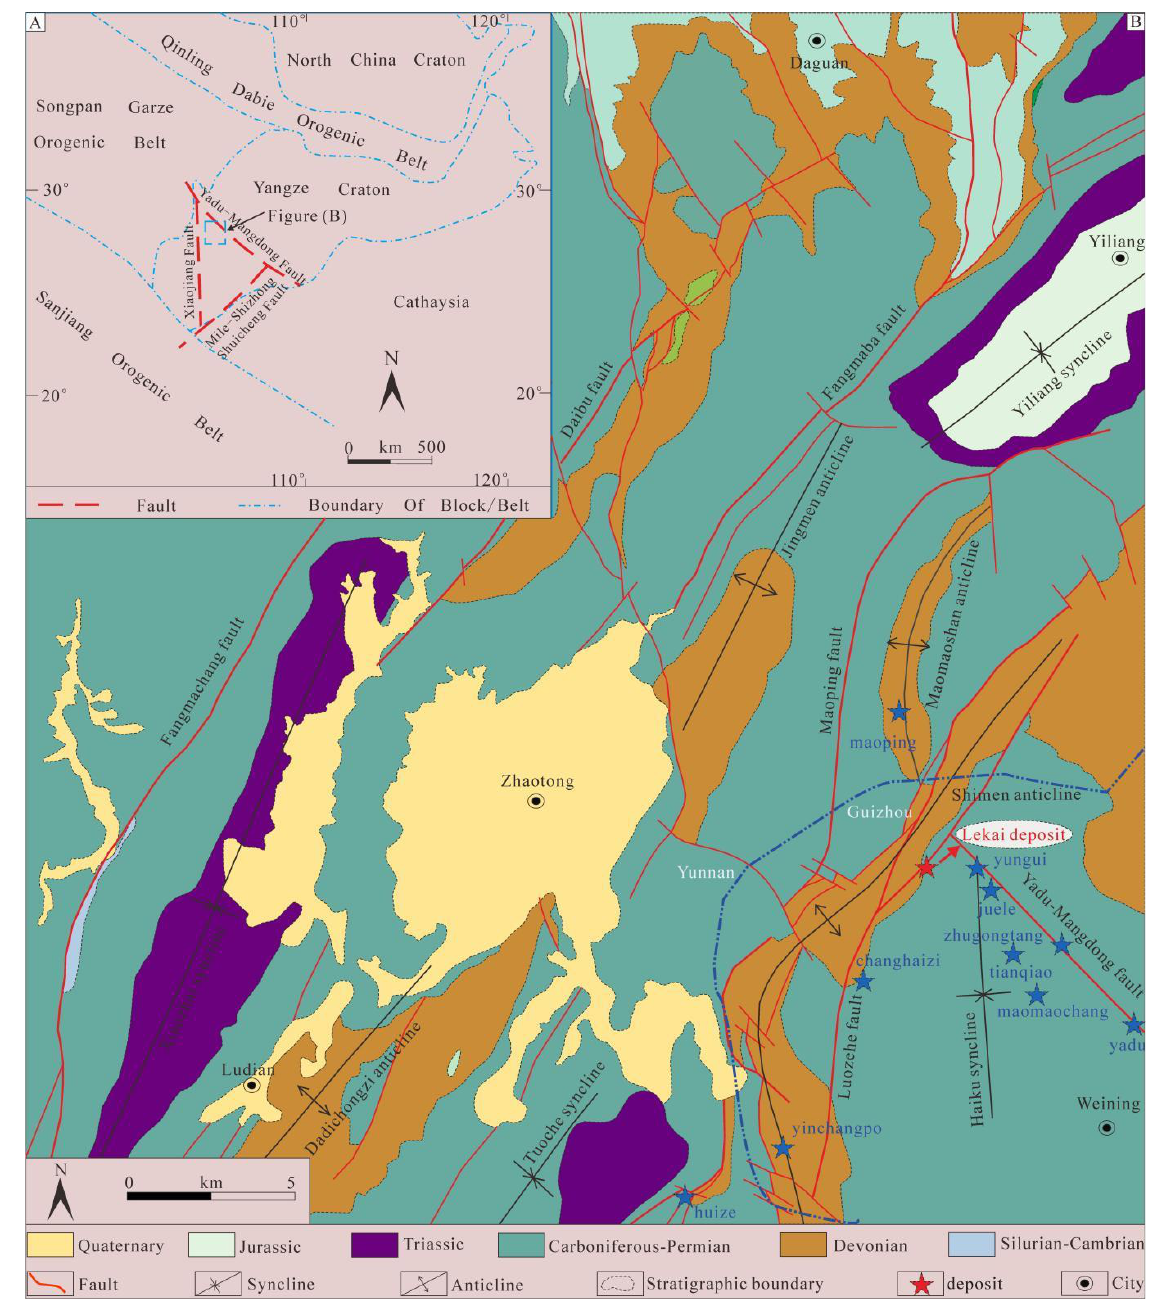
Figure 1. ( A ) Regional geological framework of south China [7]; ( B ) Regional geological map of Lekai Pb-Zn deposit in SYG Pb-Zn metallogenic province [30].